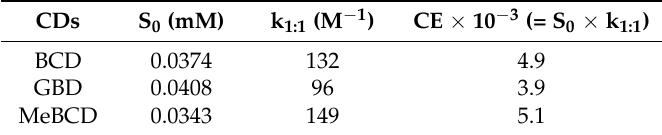
Table 1. The intrinsic solubility of piroxicam (Prx), the complex formation constants and the complexation efficiency of Prx–CDs